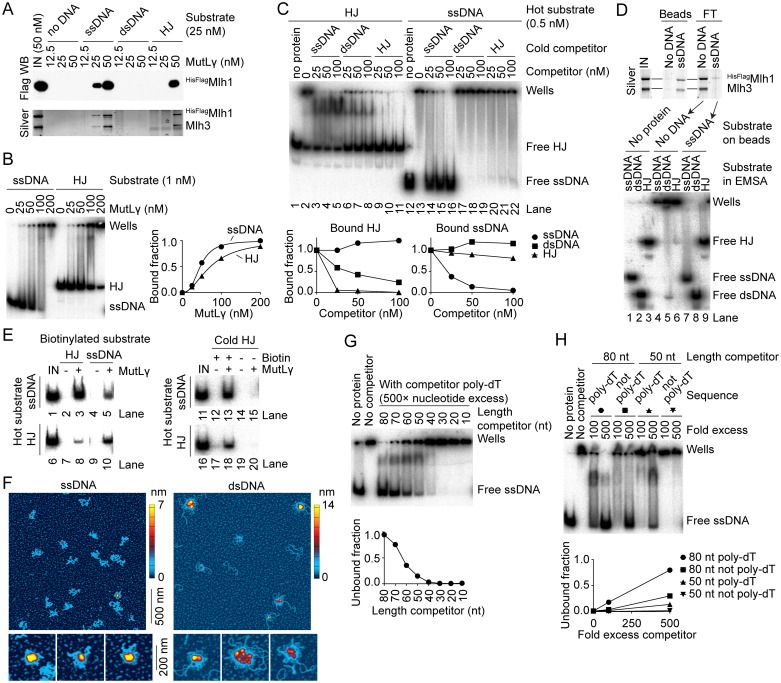
DNA-binding properties of MutLγ.A. Binding of HisFlagMlh1-Mlh3 to immobilized DNA substrates. Pulled-down proteins were separated by SDS-PAGE and detected by anti-Flag western blotting (top) and silver staining (bottom). Substrates are 80 nt poly-dT (ssDNA), 80 bp dsDNA, or HJ containing 40 bp arms. B. Binding of MutLγ to 5′ end-labeled ssDNA (left) and HJ (right). MutLγ was titrated in the presence of 1 nM substrate. An autoradiograph of a 5% TAE-polyacrylamide gel is shown. Quantification of unbound substrates is plotted. The quantifications fit Hill equations with slopes of 2.9 ± 0.27 for ssDNA and 2.0 ± 0.05 for HJ, respectively, and KD of 45.9 ± 1.6 nM for ssDNA and 72.9 ± 1.3 nM for HJ, respectively (mean ± SE). C. MutLγ has specific and separable DNA-binding activities for ssDNA and HJs. Binding reactions contained 100 nM MutLγ, 0.5 nM end-labeled HJ (left) or ssDNA (right) and the indicated amount of cold competitor. An autoradiograph of a 5% TAE-polyacrylamide gel is shown. Quantification of the bound fractions is plotted. The competitor titrations were repeated ≥3 times with similar results. D. MutLγ ssDNA and HJ-binding activities are present in the same pool of proteins. The ssDNA-binding activity of MutLγ was depleted by pull-down on poly-dT ssDNA-coated streptavidin beads (top) and the flow-through (FT) was tested in an EMSA for presence of ssDNA, dsDNA and HJ-binding activity (bottom). E. Simultaneous binding to multiple substrates. MutLγ (50 nM) was incubated with equimolar concentrations of biotin-labeled and radio-labeled substrates (25 nM each). Nucleoprotein complexes were pulled down on streptavidin beads and the presence of radiolabeled DNA was assayed by gel electrophoresis and autoradiography. The control experiment in the right panel compares pulldown efficiency with and without biotin label on the cold HJ substrate. F. MutLγ forms higher-order complexes. AFM images of MutLγ bound to large ssDNA (10.4 × 103 nt, left) or supercoiled DNA (2.7 kb, right). Images are 2 μm × 2 μm. Zoomed images illustrate the structural diversity of the higher-order complexes. G. MutLγ has a preference for long ssDNA substrates. Binding of MutLγ (100 nM) to radiolabeled ssDNA (poly-dT) was competed with a 500× excess (in nt) of ssDNA substrates ranging from 10 to 80 nt. Quantification of the unbound fraction is plotted. H. The ssDNA-binding activity of MutLγ depends on the size and sequence of the substrate. Binding to an 80 nt radiolabeled poly-dT substrate was competed with 80 nt or 50 nt substrates that are either poly-dT or a different sequence. The 50 nt non-poly-dT substrate is identical to the ssDNA previously reported not to be bound by MutLγ [46].